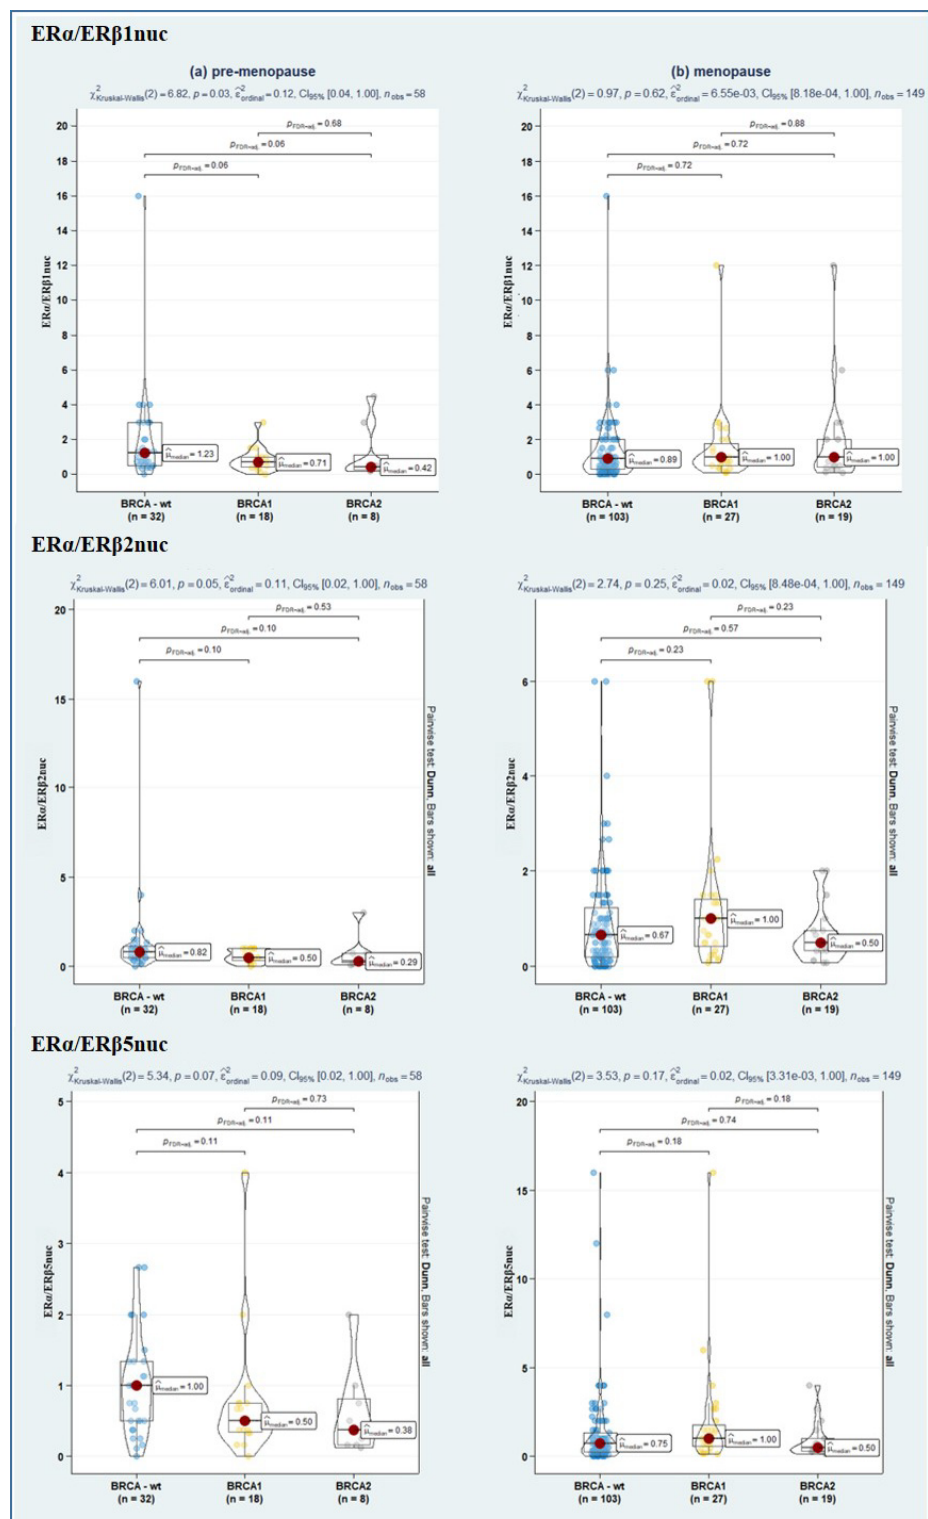
Figure 4. Violin plots depicting the relationship between ER α /ER β 1nuc ( upper panel ), ER α /ER β 2nuc ( in the middle ), and ER α /ER β 5nuc ratio ( lower panel ) in BRCA-wt, BRCA1, and BRCA2 mutated women according to menopausal status. Both overall and pairwise comparisons are reported, with FdR correction. Blue, yellow and grey dot respectively represents BRCA-wt, BRCA1 and BRCA2 patients pertaining that score of molecular marker.